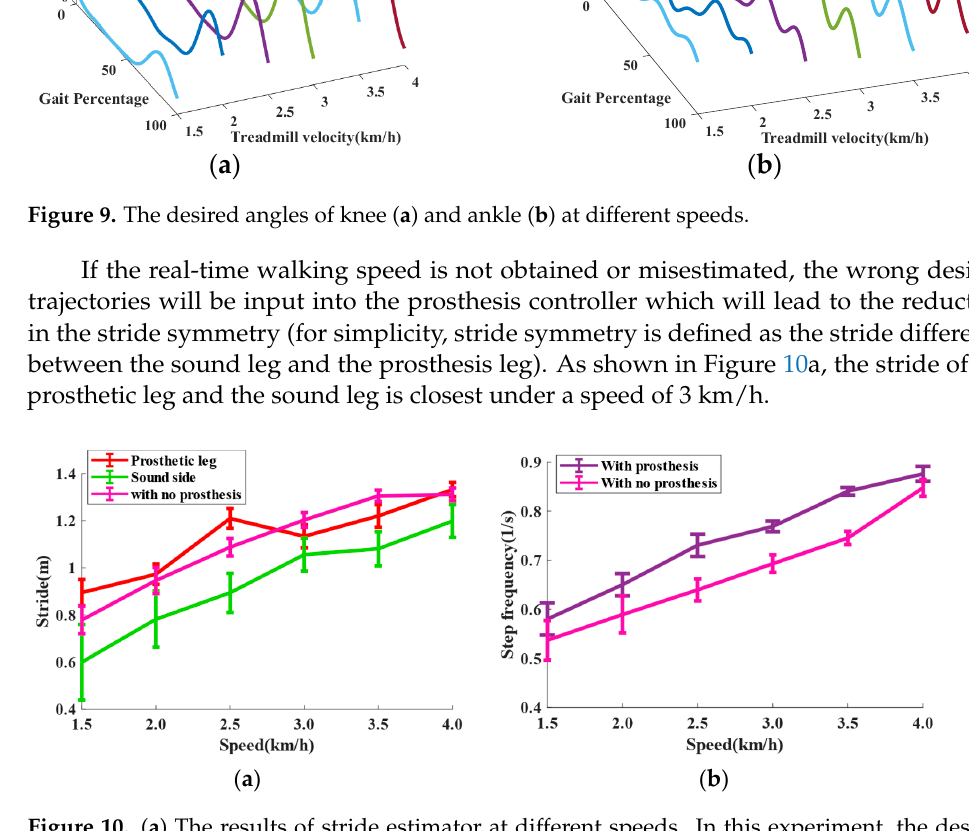
Figure 10. ( a ) The results of stride estimator at different speeds. In this experiment, the desired trajectories which is input to prosthesis controller are collected under the speed of 3 km/h. ( b ) The results of step frequency estimator at different